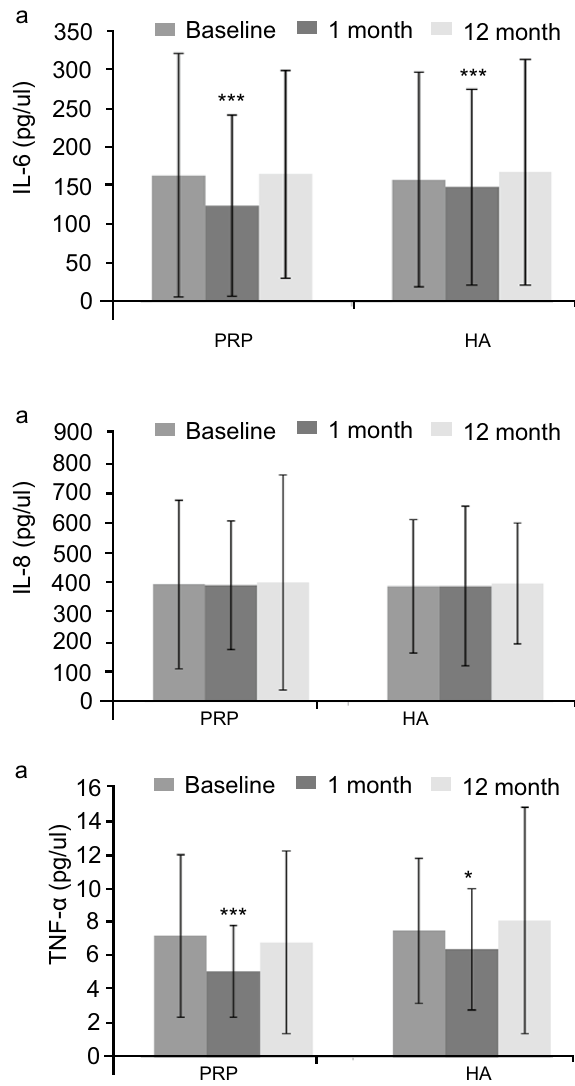
Figure 4. Level of cytokines IL6, IL8 and TNF-α in PRP and HA